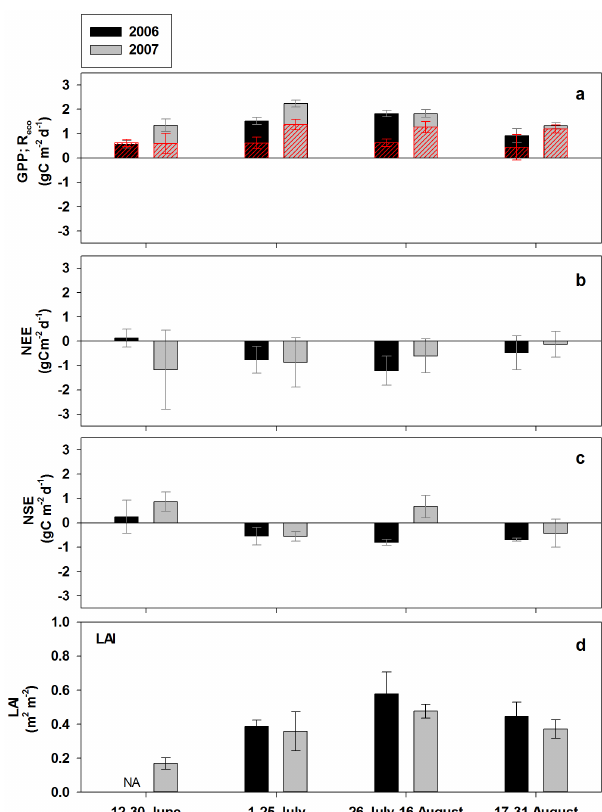
Figure 2. Ecosystem functioning during summer in 2006 and 2007 at the Barrow Environmental Observatory, Alaska; (a) gross pri- mary production (GPP) and ecosystem respiration ( R eco displayed as red hatched areas), (b) net ecosystem exchange (NEE), (c) net Sphagnum exchange (NSE), and (d) leaf area index (LAI), aver- aged for each of the indicated periods. Error bars are standard er- rors of the mean (for all samples). NA means no data available. Negative NEE and NSE represent a CO 2 sink, while positive val- ues represent C loss. The significance of differences between 2006 and 2007 values are reported in Table 2. Error bars for NEE, R eco , and GPP are propagated flux uncertainties estimated by online gap- filling (http://www.bgjena.mpg.de/~MDIwork/eddyproc/).